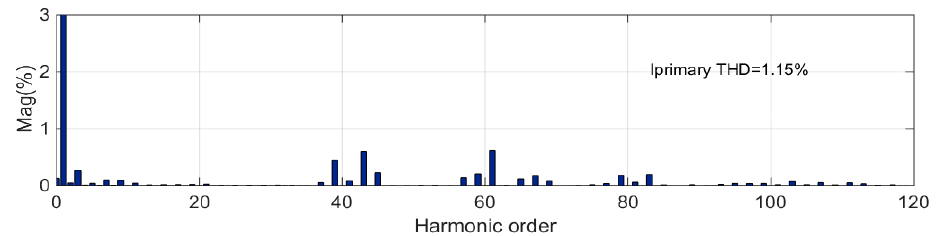
Figure 23. Fourier analysis of transformer primary current with SHE-PWM algorithm.